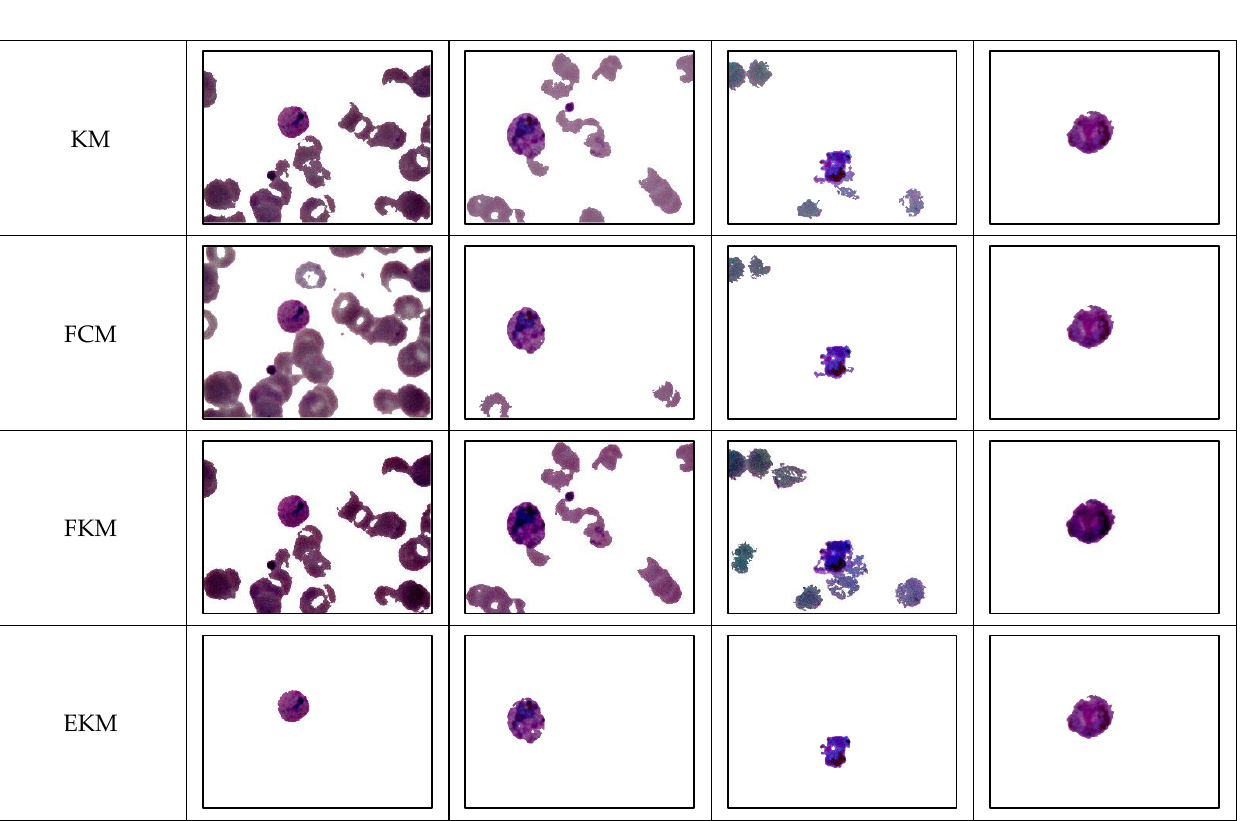
Table 3. Findings of investigated segmentation techniques on thick and thin blood smear images. Segmentation Method